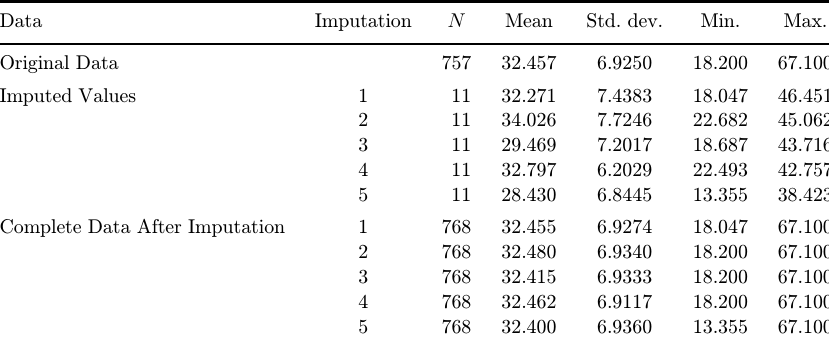
Table 6. Multiple imputations for V